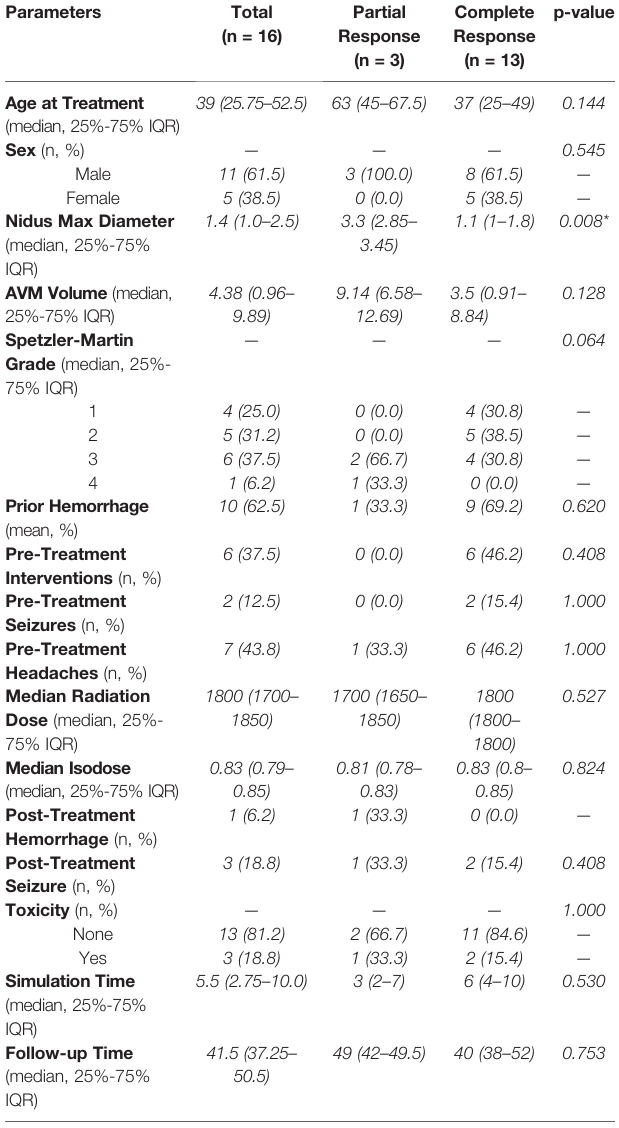
TABLE 2 | Descriptive Characteristics of AVM Response Rate. Parameters